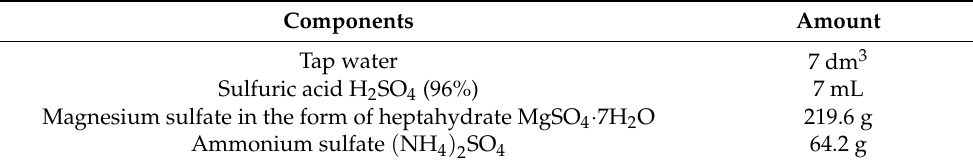
Table 5. The composition of the